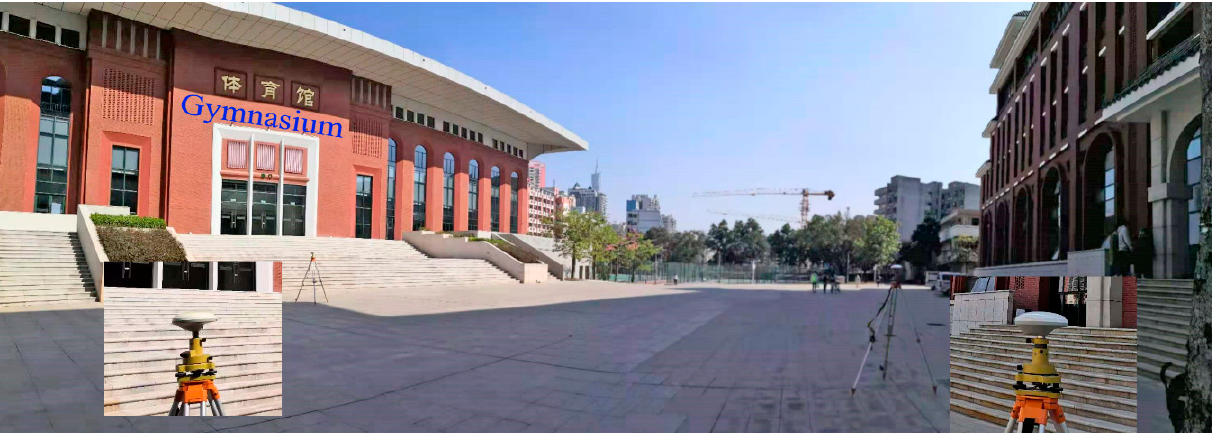
Figure 23. Data collection in SYSU campus for precise relative positioning experiment.